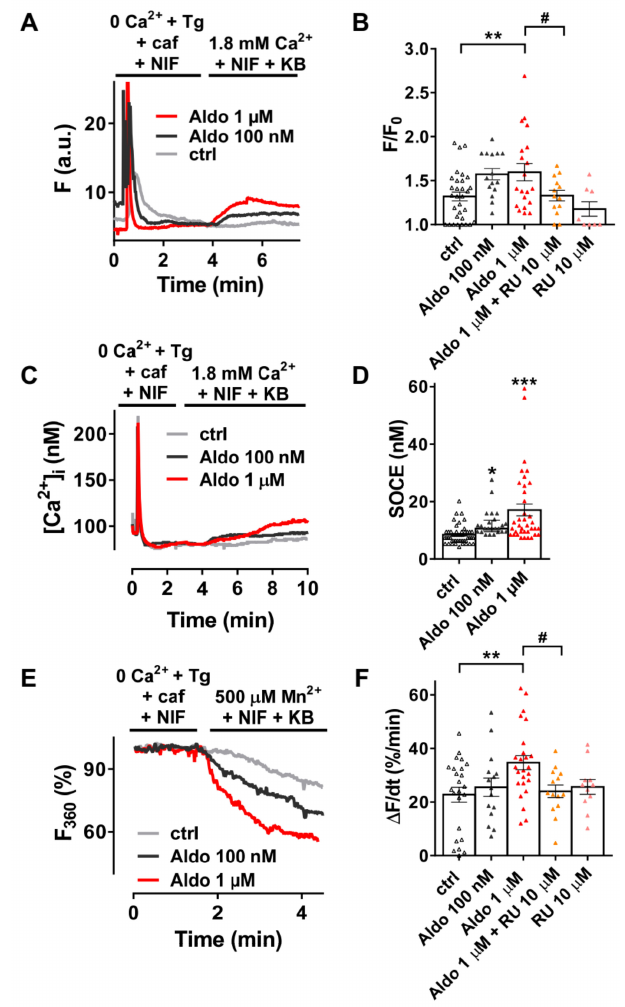
Figure 1. A 24-h aldosterone treatment increases store-operated Ca 2 + entry (SOCE) in adult rat ventricular cardiomyocytes (ARVMs). ( A ) Representative traces of fluorescence variation in Fluo-4 / AM-loaded ARVMs pre-incubated in the absence (control (ctrl), gray trace) and in the presence of aldosterone (Aldo, 100 nM, dark-gray trace or 1 µ M, red trace). Cells were exposed to 5 µ M thapsigargin (Tg) plus 10 mM ca ff eine (caf) in the presence of 10 µ M nifedipine (NIF) in Ca 2 + -free medium to deplete the SR and then to Ca 2 + -containing solution in the presence of 5 µ M of KB-R7943 and NIF to evaluate the SOCE. ( B ) Averaged amplitude of SOCE (F / F 0 ) in ARVMs incubated for 24 h in the absence (ctrl, white symbols) or in the presence of aldosterone (100 nM, gray symbols or 1 µ M, red symbols) without or with 10 µ M of the selective MR antagonist RU-28318 (RU, orange symbols in aldosterone condition and pink symbols in ctrl condition). Average results of 8–32 cells from three isolations. ( C ) Representative traces of [Ca 2 + ] i variation (in nM) in Fura-2 / AM-loaded ARVMs incubated for 24 h in the absence (ctrl, gray trace) or in the presence of aldosterone (100 nM, dark-gray trace; 1 µ M, red trace). Fura-2 / AM fluorescence 340 / 380 ratios were converted to [Ca 2 + ] i as described in the methods. ( D ) Quantitative assessment of SOCE (in nM) from untreated (ctrl, white symbols) and 100 nM (gray symbols) or 1 µ M (red symbols) aldosterone-treated cells. Average results of 24–48 cells from four isolations. ( E ) Representative traces of Mn 2 + -induced Fura-2 / AM fluorescence decay in ARVMs incubated in the absence of aldosterone (ctrl) are shown in gray traces, and those in the presence of aldosterone 100 nM or 1 µ M are shown in dark-gray and red traces, respectively. ( F ) Bar graph of the initial slope of the Mn 2 + -induced decrease of Fura-2 / AM fluorescence fitted by linear regression and averaged ( ∆ F / d t , % / min) for ARVMs incubated for 24 h in the absence (ctrl, white symbols) or in the presence of aldosterone (100 nM, dark-gray symbols or 1 µ M, red symbols)